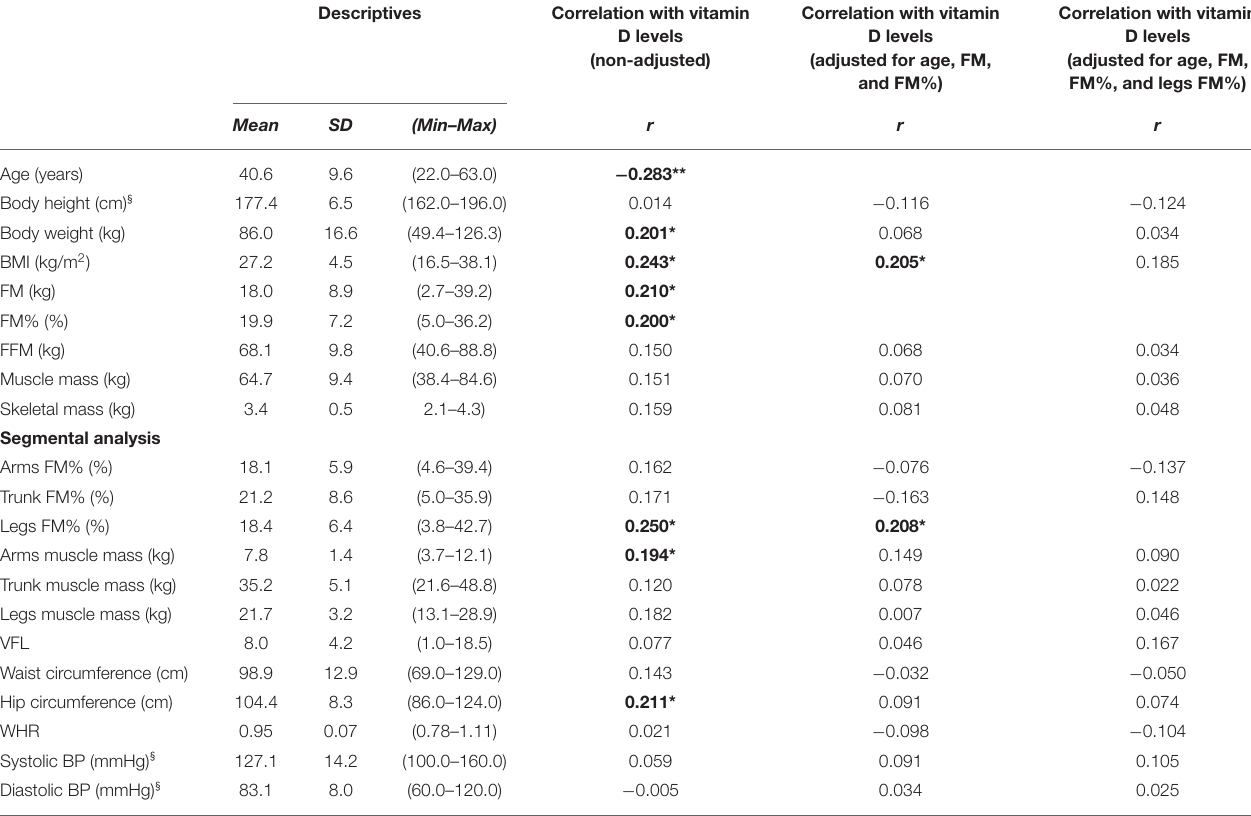
Descriptives Correlation with vitamin